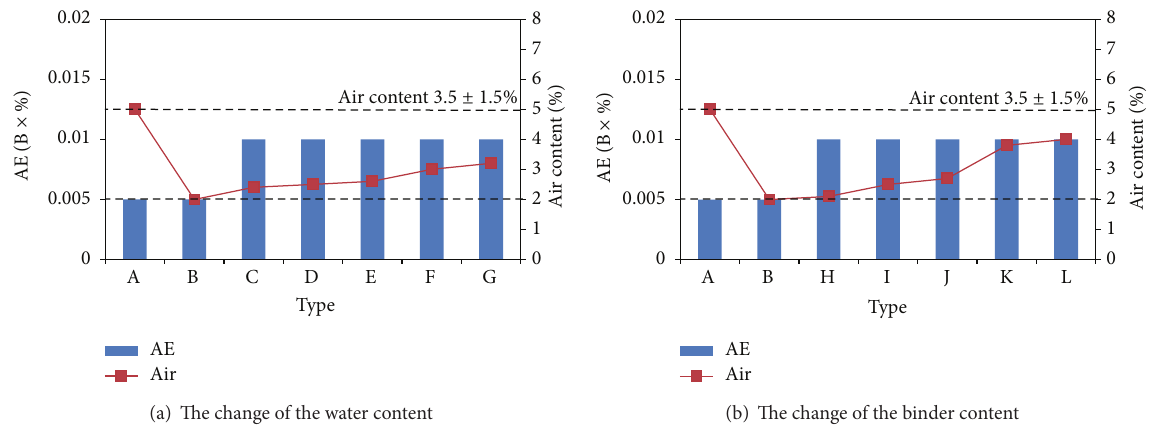
Figure 2: The air content of high volume fly ash HFC with air-entraining agent content.